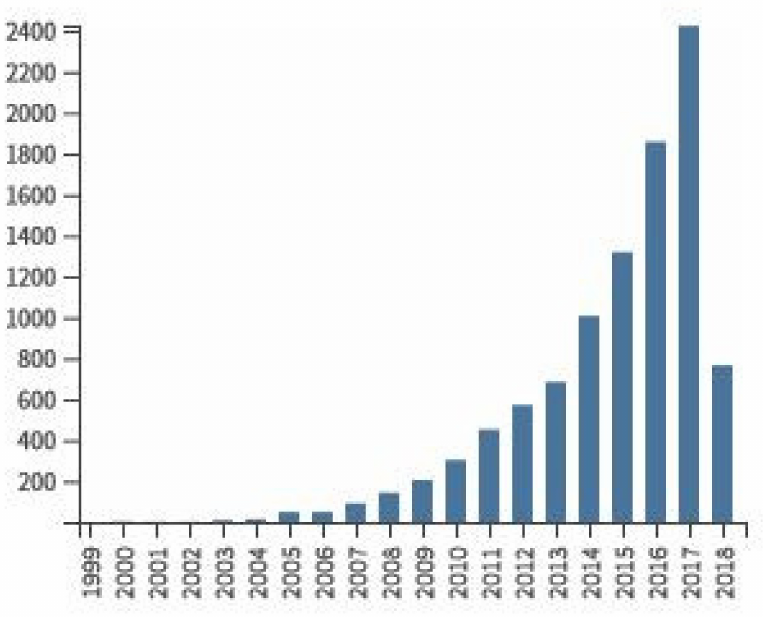
Figure 11. Growth of publications in nanofluids [77] © Elsevier,